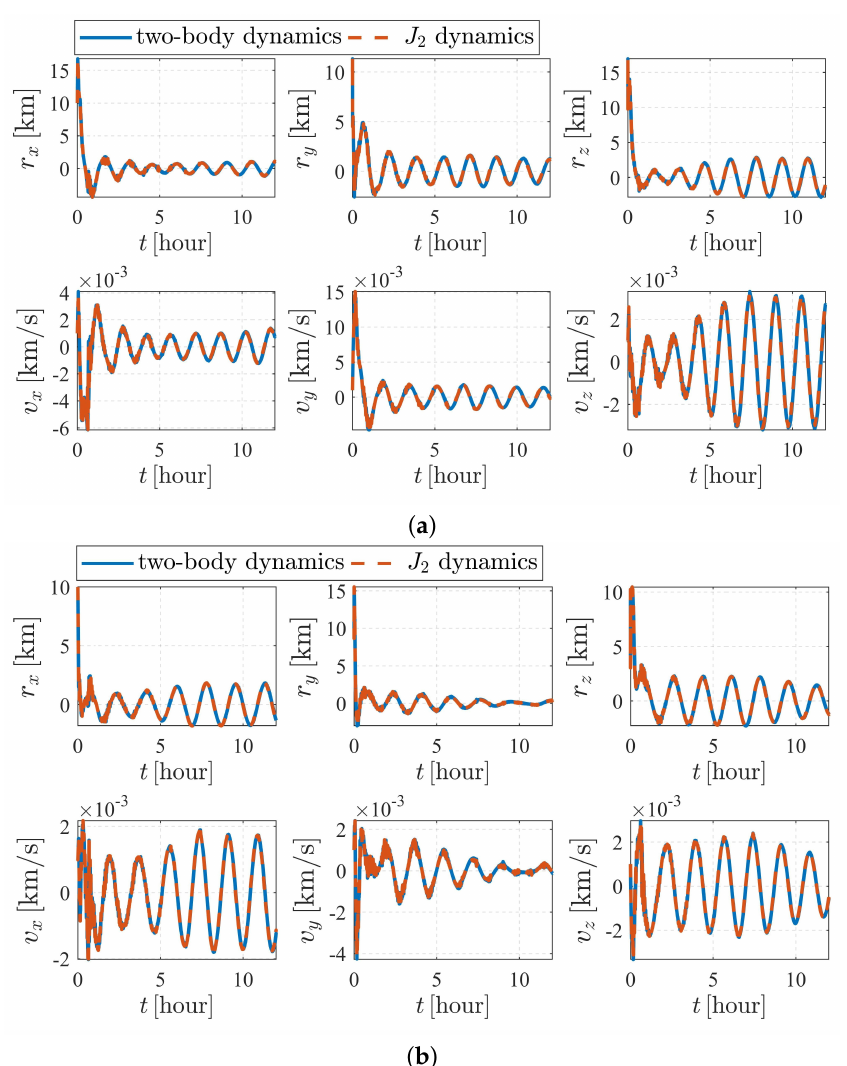
Figure 10. Orbit determination errors of case III (nonperturbation and with J 2 perturbation). ( a ) Orbit estimation errors of spacecraft S 1 . ( b ) Orbit estimation errors of spacecraft S 2